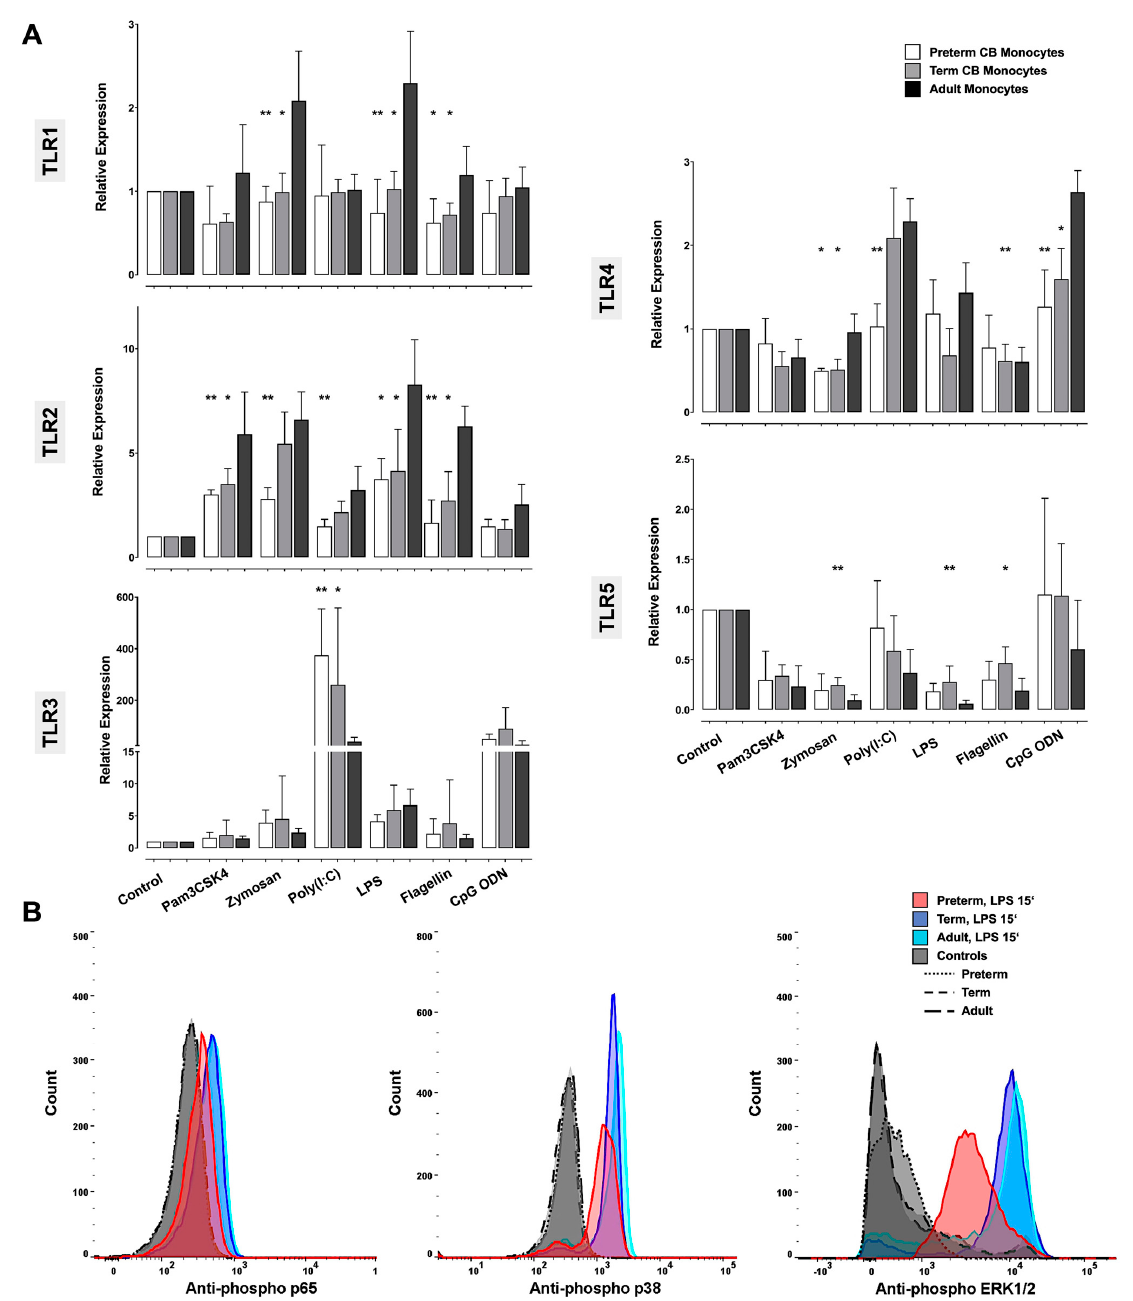
Figure 3. ( A ) Stimulus-induced mRNA expression of TLR1, 2, 3, 4, and 5 in preterm CB (white bars), term CB (grey), and adult monocytes (black) at baseline and upon Pam3CSK4, zymosan, poly(I:C), LPS, flagellin, and CpG ODN stimulation. Values represent the means ± SD (* p < 0.05, ** p < 0.01, vs. adult monocytes). For reason of chart readability, differences in expression levels within one group are presented in the text. ( B ) Stimulus-driven phosphorylation of p65, p38, and ERK1/2. Representative overlaid flow cytometer histograms show staining of phospho-p65, phospho-p38, and phospho-ERK1/2 in preterm CB (red), term CB (blue), and adult monocytes (turquoise) exposed to the TLR4 ligand LPS compared with unstimulated controls (grey; dashed and dotted lines).